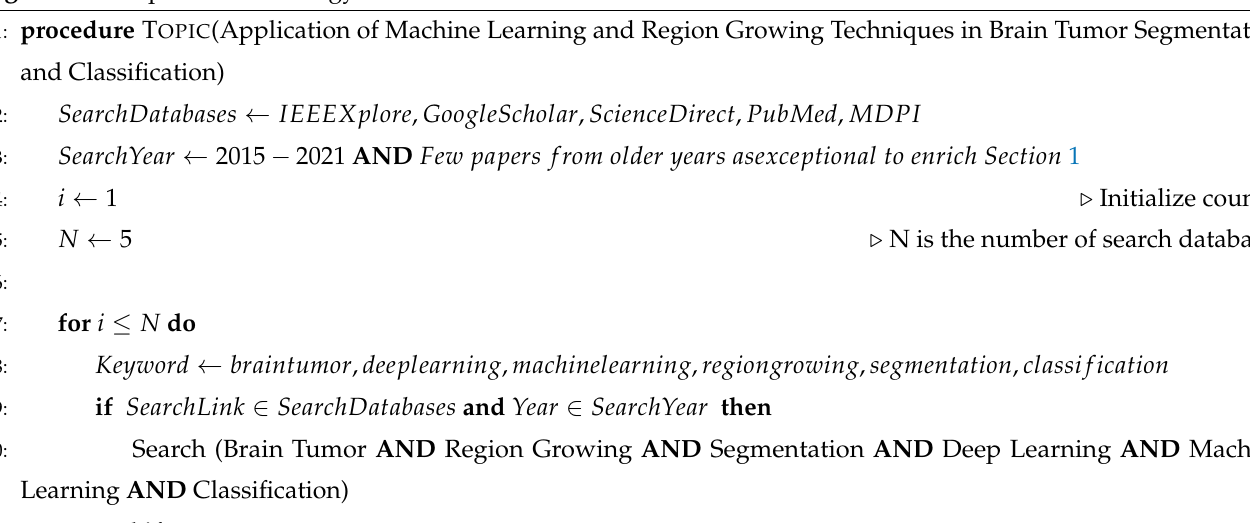
Algorithm 1 Paper search strategy from different search